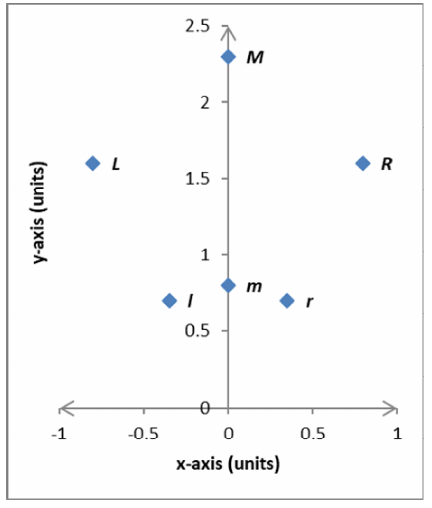
Figure 8. Positions of the six target locations.